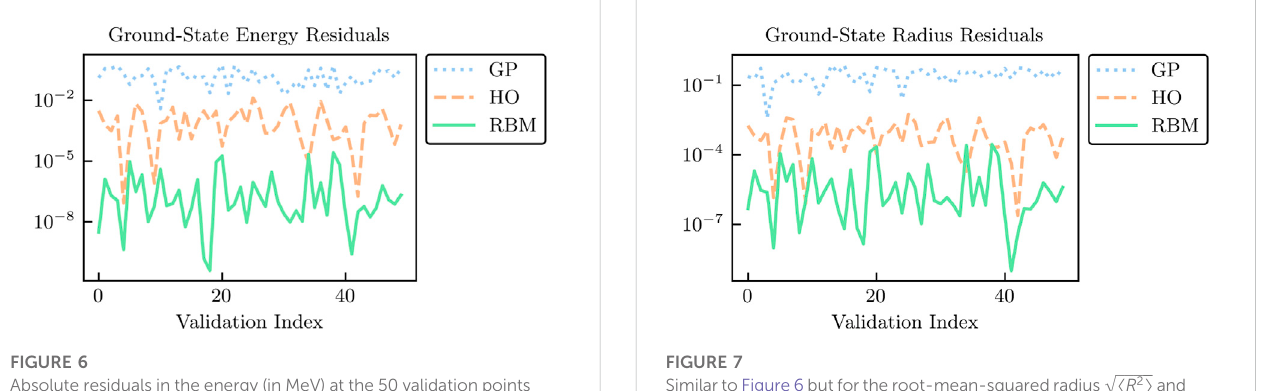
FIGURE 7 SimilartoFigure6butfortheroot-mean-squaredradius in units of fm.